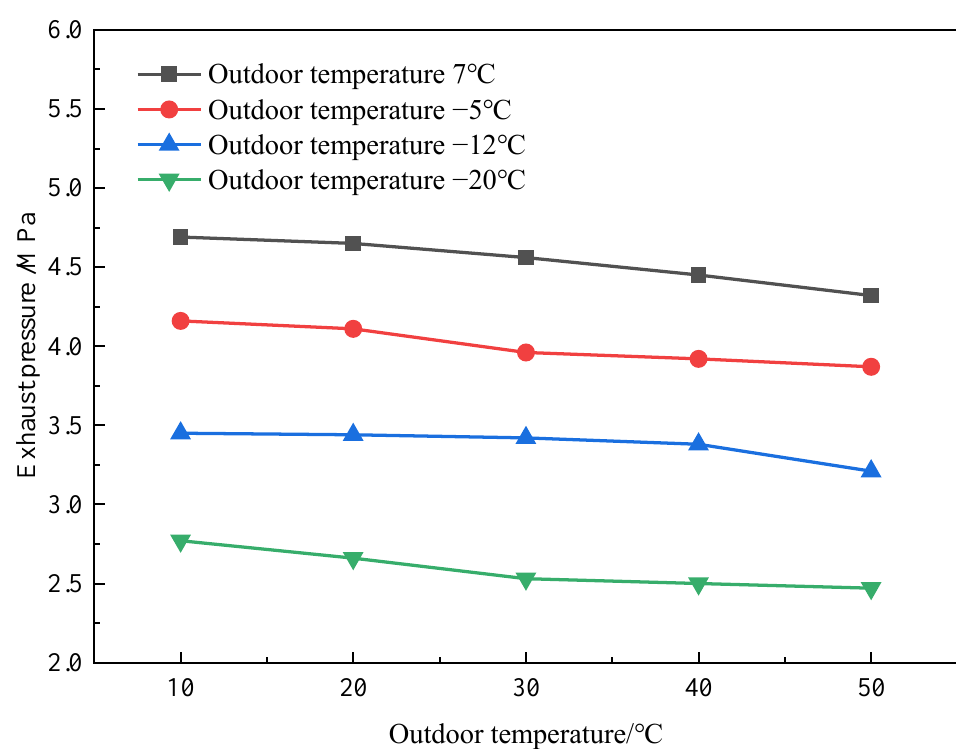
Figure 11. Compressor exhaust pressure changes under different operational conditions.